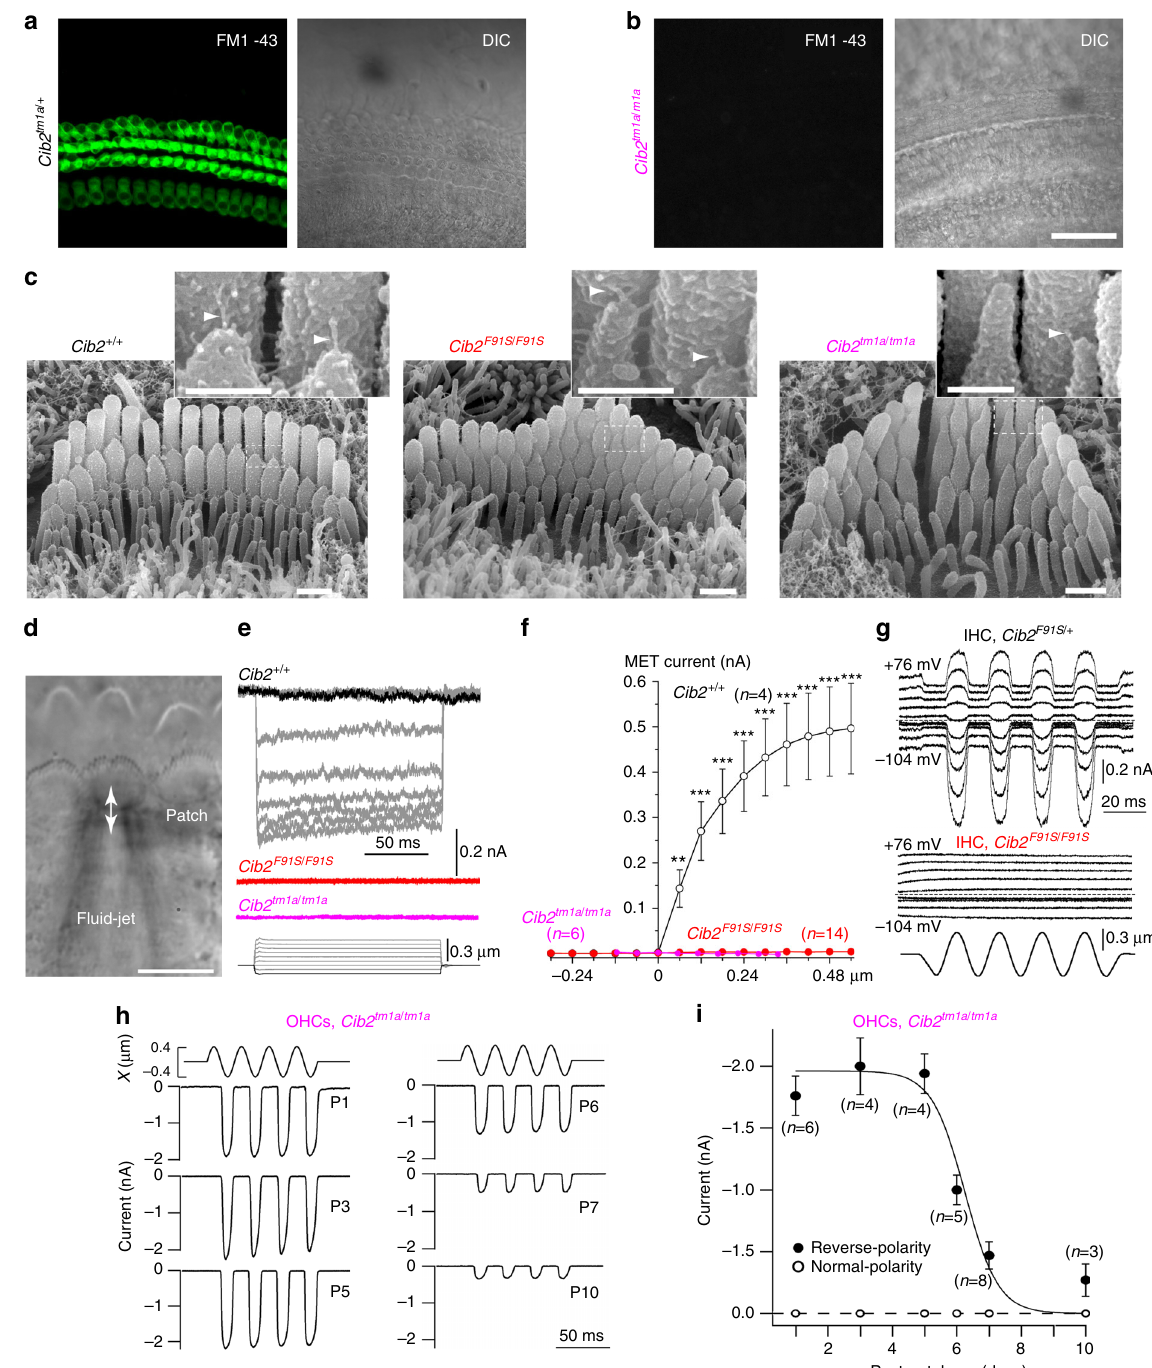
Fig. 5 CIB2 is essential for mechanotransduction in the auditory hair cells. a , b Maximum intensity projections of Z-stacks of confocal fl uorescent images ( left ) and corresponding DIC images ( right ) of control ( a ) and Cib2 tm1a/tm1a ( b ) cultured organ of Corti explants imaged after exposure to 3 μ M of FM1-43 for 10 s. The samples were dissected at P5 and kept 2 days in vitro (P5 + 2 div ). Scale bar: 20 µ m. c SEM images of IHCs in acutely isolated organ of Corti explants from wild-type ( left ), Cib2 F91S/F91S ( middle ), and Cib2 tm1a/tm1a ( right ) mice. Insets show the tip links at high magni fi cation in the areas indicated by dashed boxes . Scale bars are 0.5 µ m and 200 nm in the insets ( d ). Experimental setup for MET current recordings. Positive pressure in fl uid-jet de fl ects hair bundle toward kinocilium and activates “ conventional ” MET channels gated by tip link tension, while negative pressure closes these channels but may activate “ reverse-polarity ” currents at certain conditions 51, 52 . Scale bar is 10 µ m ( e , f ) MET current traces ( e ) and average MET current (Mean ± SEM) ( f ) to the graded de fl ections of the hair bundles with fl uid-jet ( bottom traces in e ) in wild-type ( black and grey ), Cib2 F91S/F91S (red), and Cib2 tm1a/tm1a ( magenta ) IHCs. Statistical signi fi cance is indicated with asterisks : ** p < 0.01, *** p < 0.001 (Student ’ s t -test). g MET responses produced by a sinusoidal fl uid-jet stimulus ( bottom ) in control Cib2 F91S/ + ( top traces ) and Cib2 F91S/F91S ( middle traces ) IHCs at different holding potential ranging from − 104 to +76 mV (indicated by the traces ). Age of the IHCs in e – g : P4 – P7. h Reverse-polarity current in the OHCs of Cib2 tm1a/tm1a mice at different developmental ages indicated by the traces. Note that the current is activated by negative but not positive bundle de fl ections. i Average values (Mean ± SEM) of normal and reverse-polarity currents in Cib2 tm1a/tm1a OHCs at different ages. Number of cells is indicated by each data